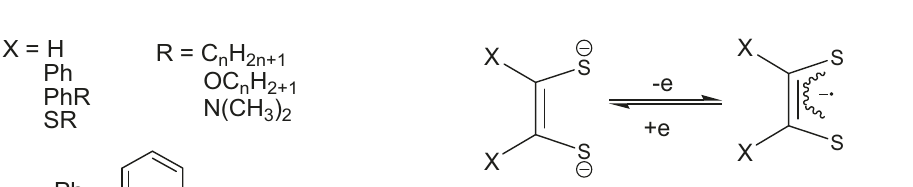
(DA) is jetted into areas where the fusing action will be reduced and into part boundaries to produce sharp and smooth edges for geometrically accurate parts throughtheprocessofevaporativecooling.Anewlayerofpowderisspreadontop of the previous layer and the process (print, fuse, spread) is repeated until the full object is formed.